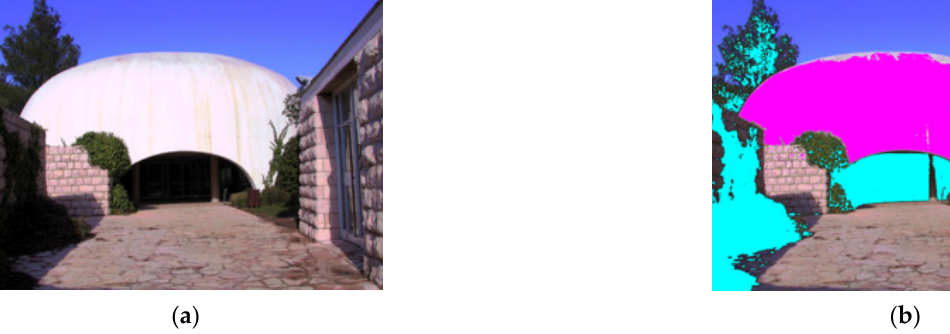
Figure 3. An example of highlight/shadow detection. ( a ) The pilot image (pre-processed using the method of [19]). ( b ) Detection results from the proposed method, where the pink and cyan areas indicate highlights and shadows, respectively.